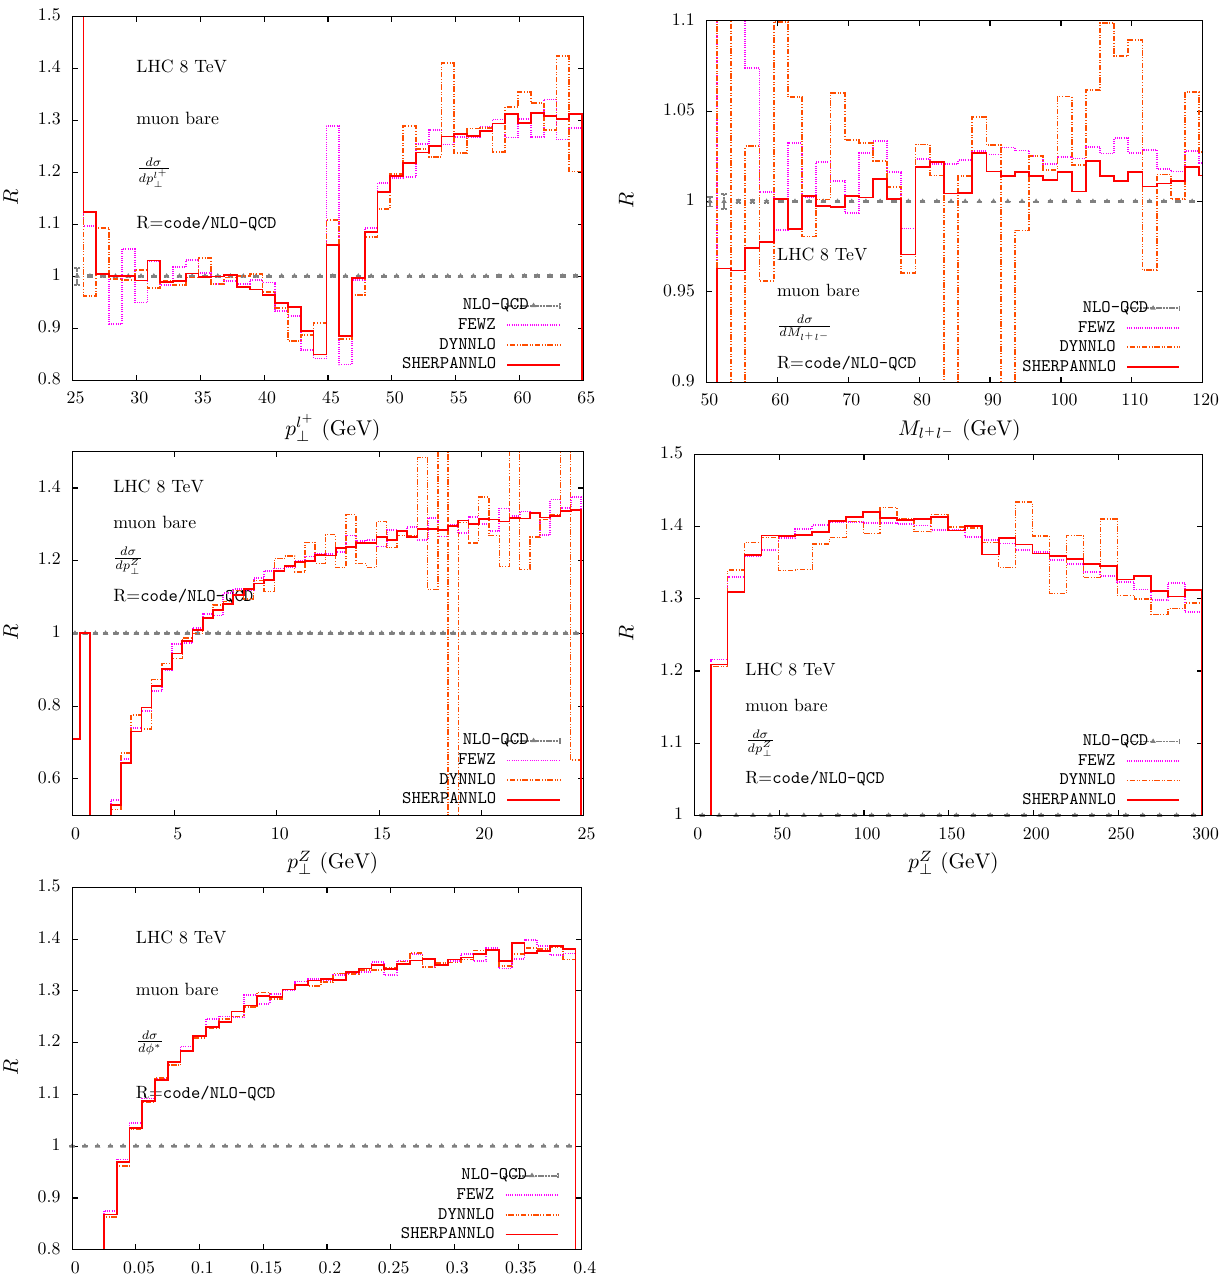
pair transverse momentum ( middle plots ), φ ∗ ( lower plot ) distribu- tions, as predicted by SHERPA-NNLO-FO ( red ), FEWZ ( pink ) and DYNNLO ( orange dashed )